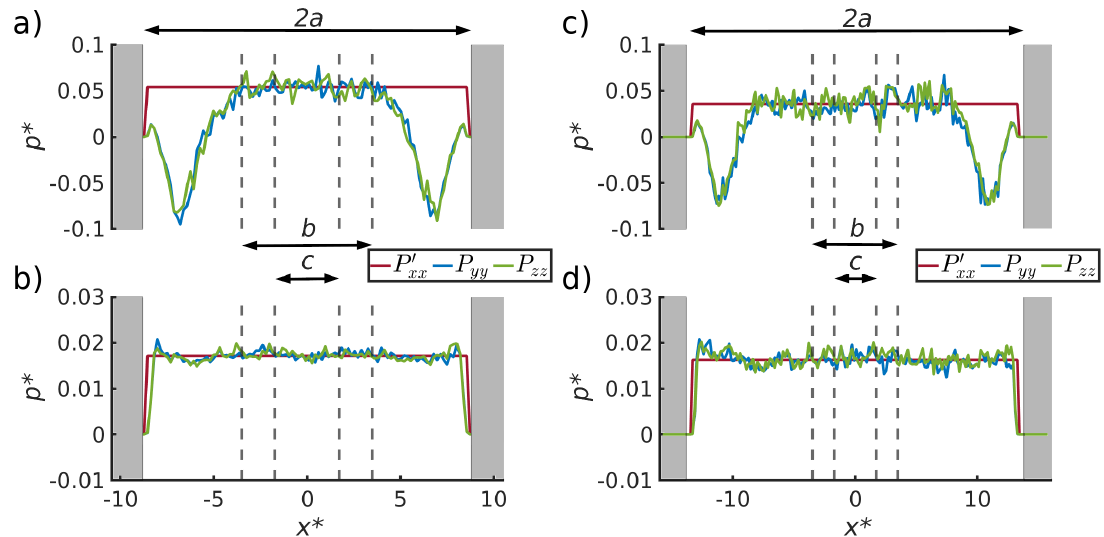
Figure 4. Pressure variation of the three pressure components normal to the surface shown for ( a ) the liquid phase with pore width 17.4 σ 0 , ( b ) the vapor phase with pore width 17.4 σ 0 , ( c ) the liquid phase with pore width 27.4 σ 0 and ( d ) the vapor phase with pore width 27.4 σ 0 , for α sf = 0.15. The normal component of the pressure, P (cid:48) xx , is extrapolated from the center of the slit pore. In the liquid phase (top), the tangential pressure component becomes negative close to the surface. This variation was used to compute the surface tension between solid and liquid from Equation